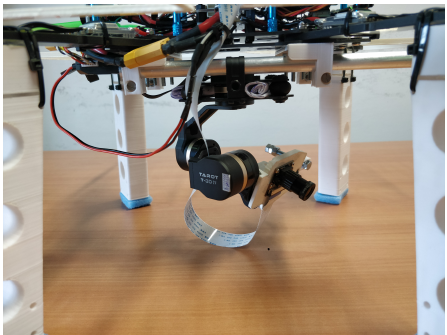
Figure 4. 3-DOF gimbal stabilizing the Raspicam camera and thus decreasing the so-called video noise. Indeed, if we do not use the gimbal, the low refresh rate of the camera data stream is responsible for the generation of video noise contributions due to high-frequency changes of the drone attitude. Video noise implies blurred